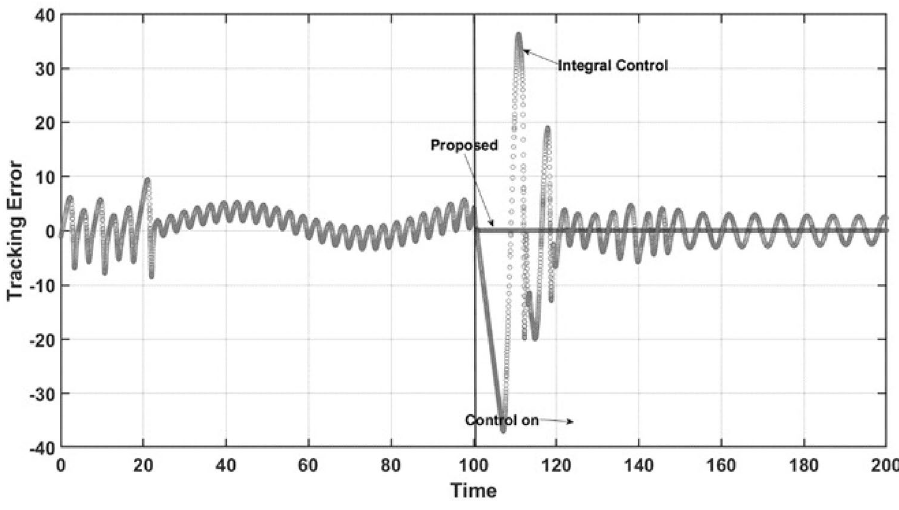
Figure 12. Tracking trajectory